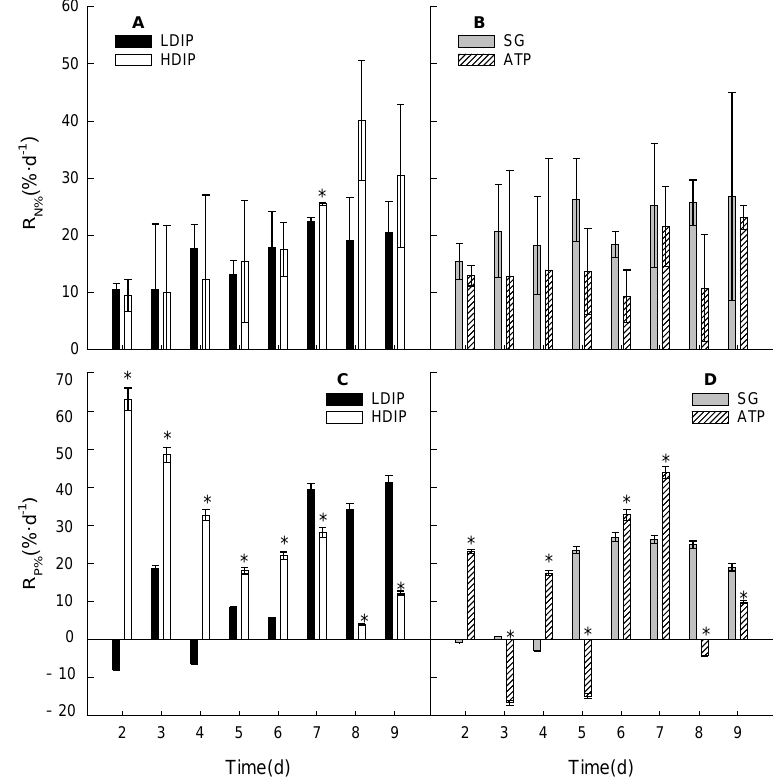
Figure 7. Changes in the daily absorption rates of nitrate and phosphate in the water of C. roscof- fensis culture groups of inorganic ( A , C ) and organic ( B , D ) initial phosphorus resources. (LDIP): low concentration of inorganic phosphorus; (HDIP): high concentration of inorganic phosphorus; (SG): Na 2 -glycerophosphate; (ATP): adenosine triphosphate. * statistical significance, p < 0.05.